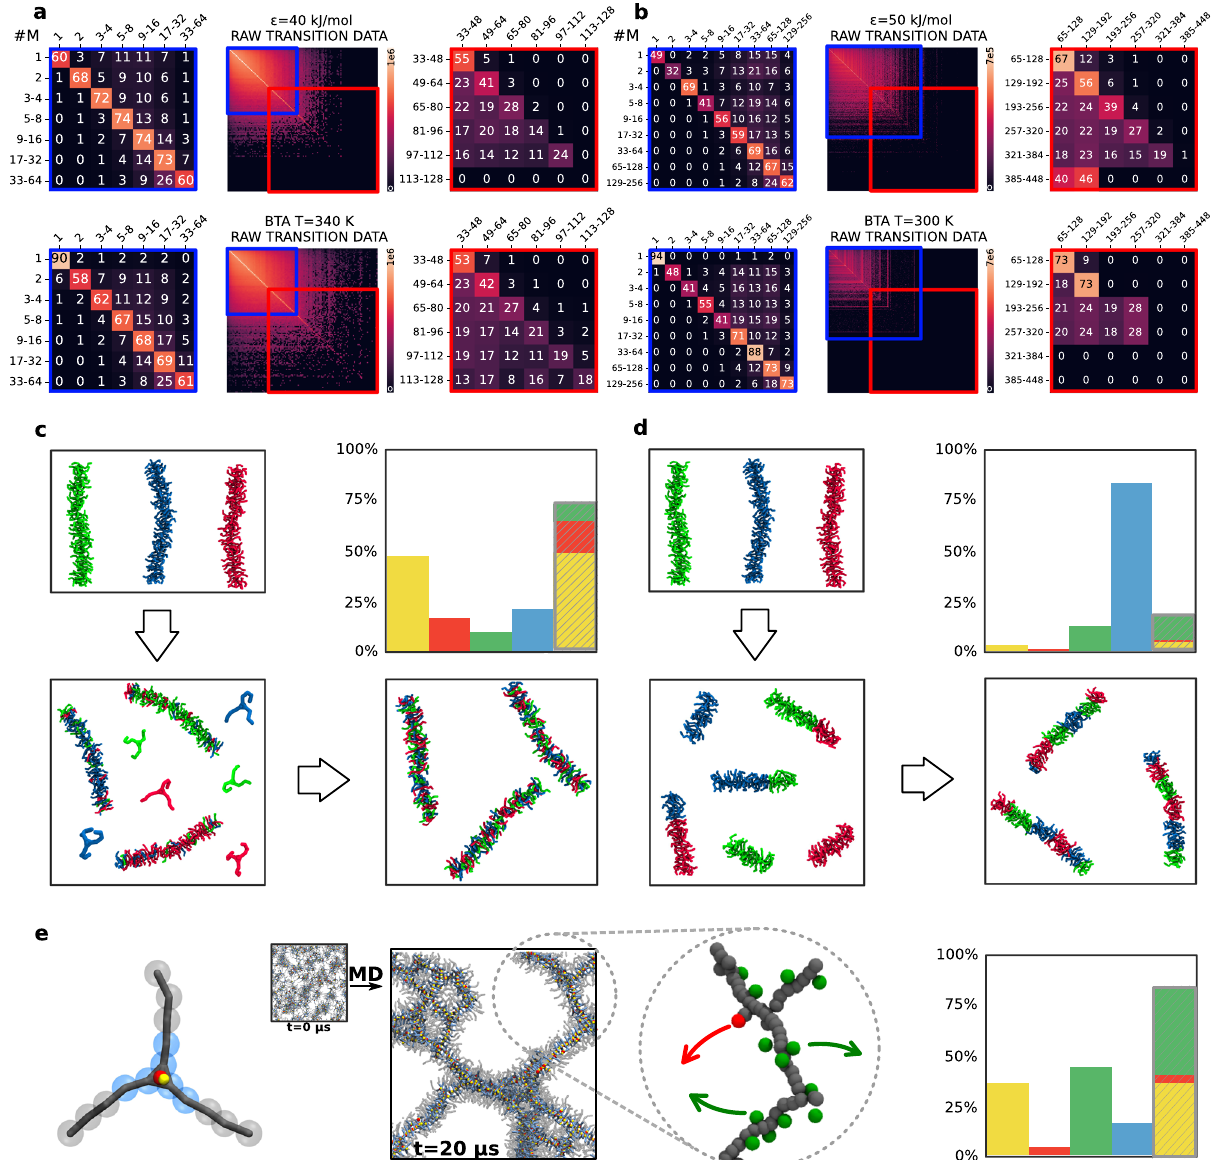
Fig. 5 Equilibrium dynamics in supramolecular polymer systems. a Raw transition matrix (centre) and transition probability sub-matrices (left and right, as in Fig. 2a), comparing the M system with ϵ = 40 kJ mol − 1 (top) and the BTA system at T = 340 K (bottom). b Same as ( a ), comparing the M system with ϵ = 50 kJ mol − 1 (top) and the BTA system at T = 300 K (bottom). c , d Illustrative schemes of the mechanisms of inter-assembly communication. When the interaction between the self-assembling units is weaker (lower ϵ , or higher T ), the fi bres preferably communicate with each other exchanging monomers or relatively small fragments. When the interaction between self-assembling units is stronger (higher ϵ , or lower T ), the inter-assembly communication proceeds mostly via large fi bre fragmentation and coalescence. The histograms indicate the incidence of the four communication mechanisms detailed in the text. The same colour coding of Fig. 3e is used. e Comparison with a model of water-soluble BTA supramolecular polymers ( BTA w : where the monomers are amphiphilic, and solvophobic effects are non-negligible). Left: structure of the BTA w monomer: the monomer cores (blue beads) attract each other with interaction strength ϵ = 4 kJ mol − 1 , to reproduce the solvophobic effect. Centre-left: snapshot of BTA w fi bres formed spontaneously after t CG = 20 μ s of CG-MD (starting from 500 dispersed BTA w monomers, small inset). Centre-right: detail of the BTA w fi bres, highlighting the presence of defects all along the fi bres backbone (the spheres represent the centres of the monomers, bulk defected domains are highlighted in green, defected domains akin to fi bre tips are highlighted in red — see also Supplementary Fig. 32). Mechanism histogram, showing that the fi bres preferably communicate with each other exchanging monomers or relatively small